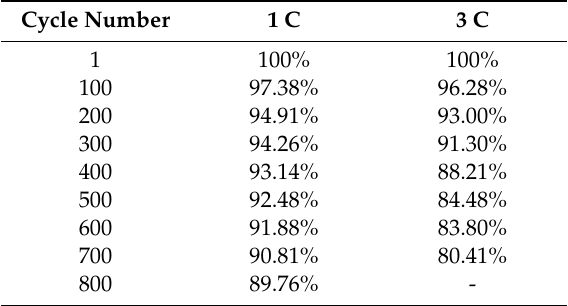
Table 7. Calculated SoH at 25 ◦ C based on the Qm computed from the ECBE model.